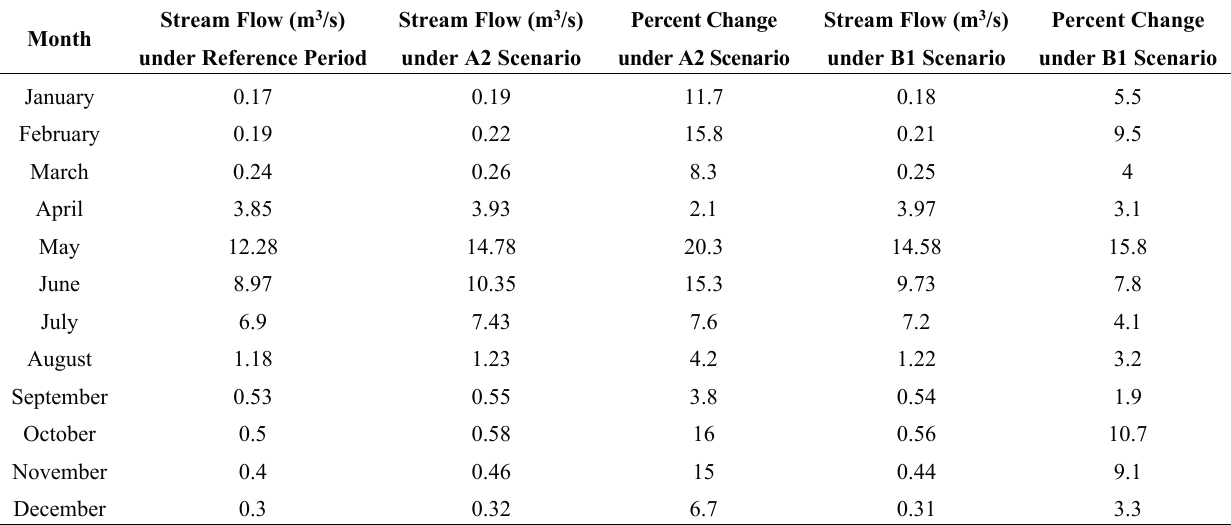
Table 3. Mean monthly stream flow during the reference period (2000–2011) and A2 and B1 scenarios for the long-term period (2020–2040), and projected percent change in mean monthly stream flow in the A2 and B1 scenarios for the long-term period (2020–2040) with respect to that under the reference period (2000–2011).